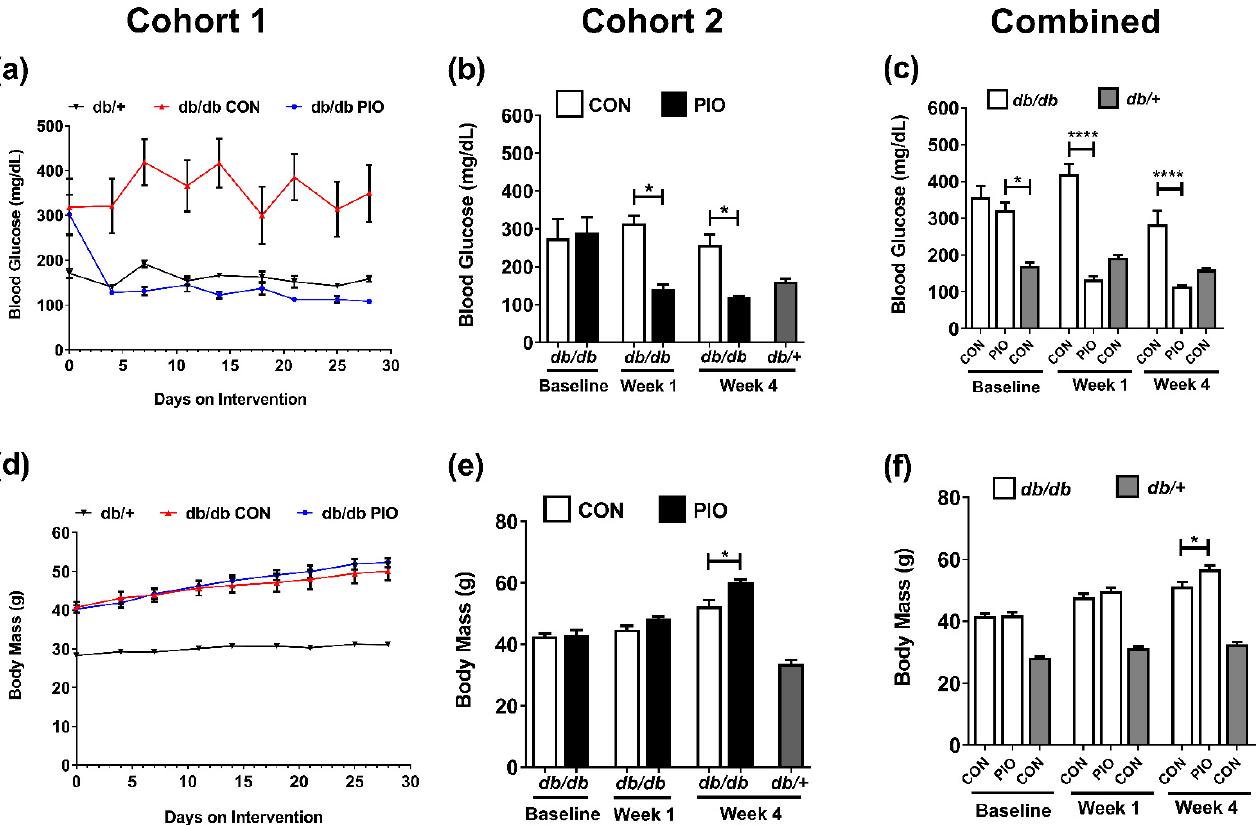
Figure 1. Dietary supplementation of pioglitazone (PIO) alleviates hyperglycemia in db/db mice. ( a – c ) Blood glucose in db/+ mice on a control diet, and db/db mice on either a control (CON) or pioglitazone (PIO)-supplemented diet for 28 d starting at 8 weeks of age. ( d – f ) Body mass in db/+ mice on a control diet, and db/db mice on either a CON or PIO-supplemented diet for 28 d. Data from cohort 1 are represented in Figure 1a,d (n = 6 per group), cohort 2 is shown in Figure 1b,e (n = 8 per group), and data compiled from both cohorts are shown in Figure 1c,f (n = 14 per group). Data are represented as the means ± SEM. * p < 0.05, **** p <